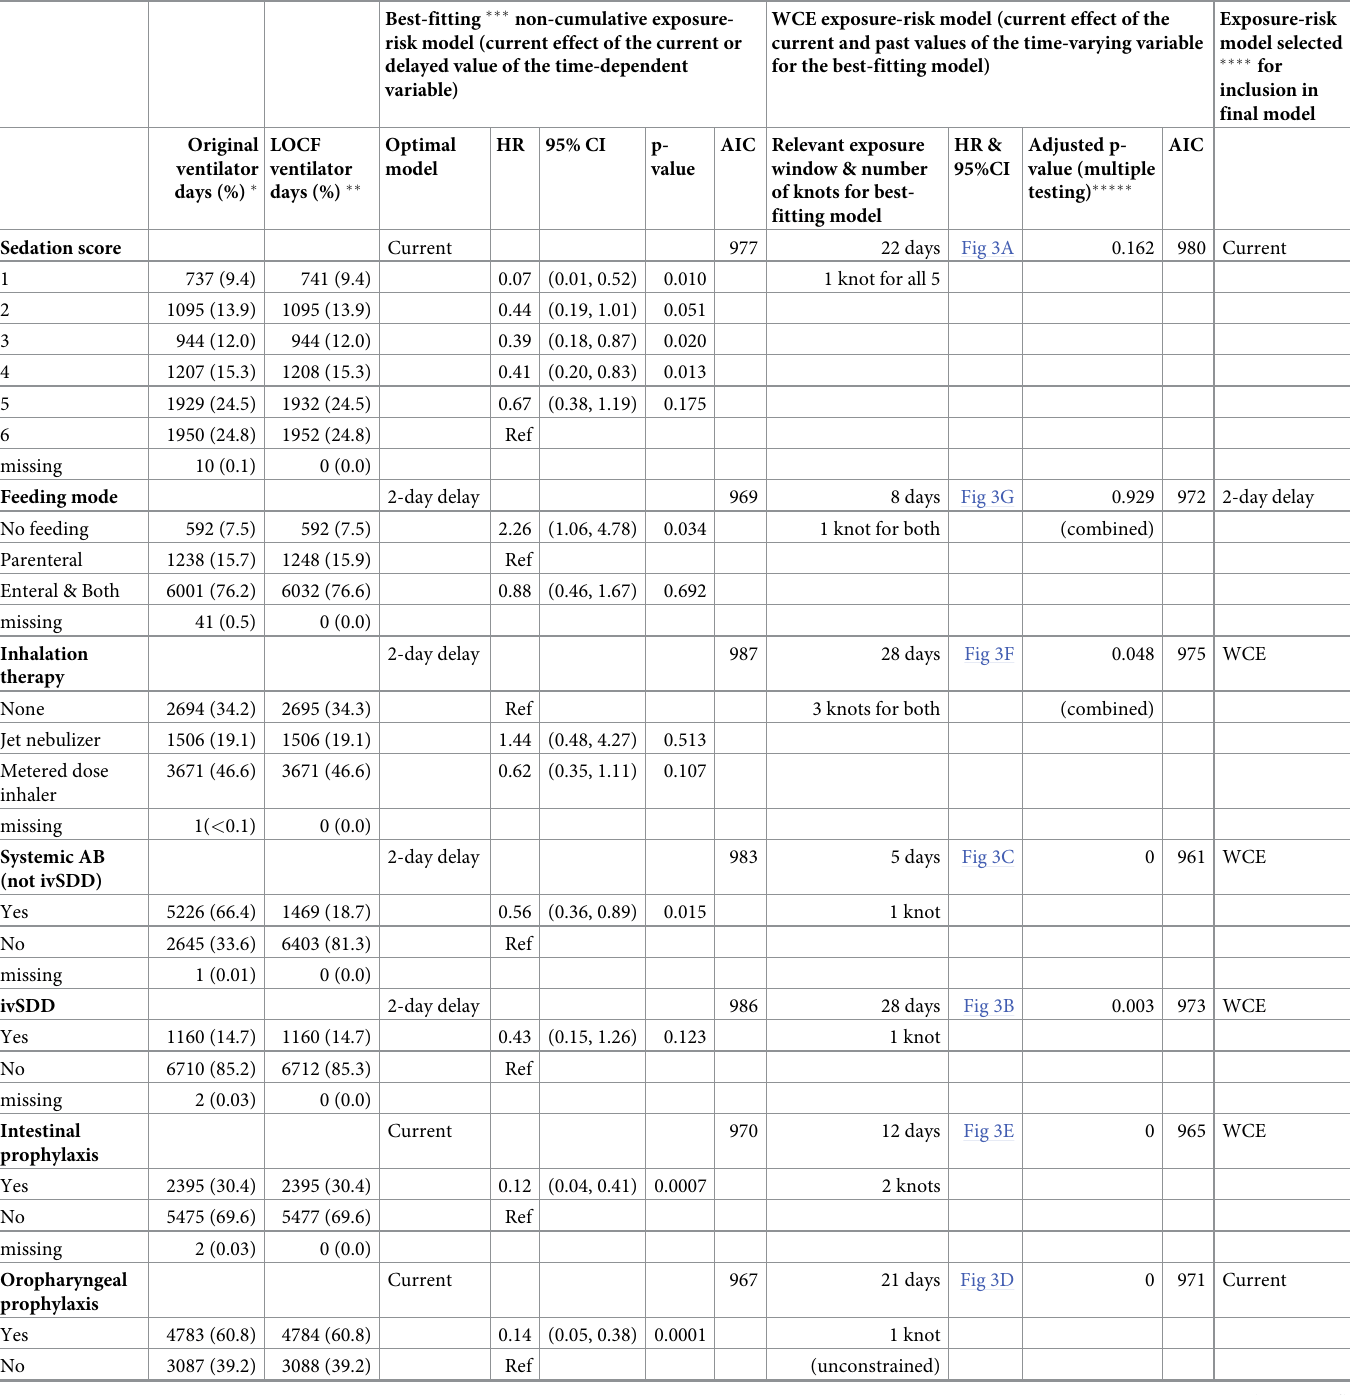
Table 2. Ventilation day characteristics and hazard ratios for univariate models of time-dependent